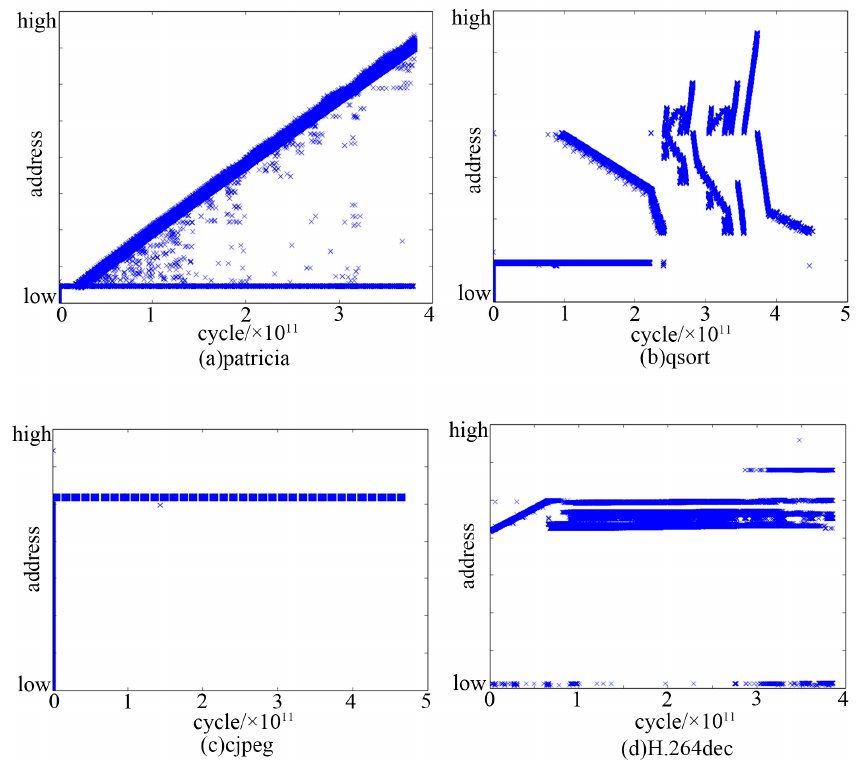
Figure 4. Concentration of write operations.